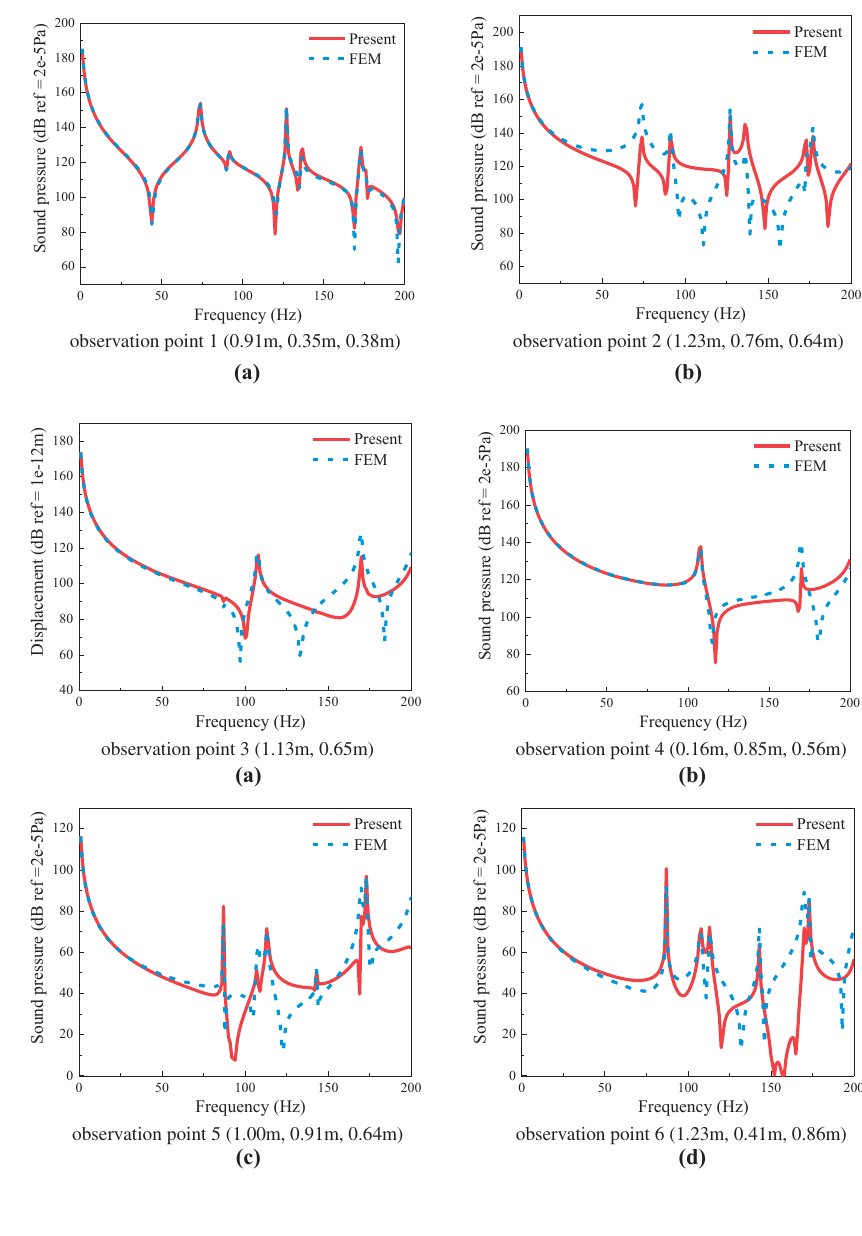
Figure 9. The displacement and sound pressure response curves of the rotary composite laminated plate and conical – cylindrical double cavities coupled system with the excitation of a point